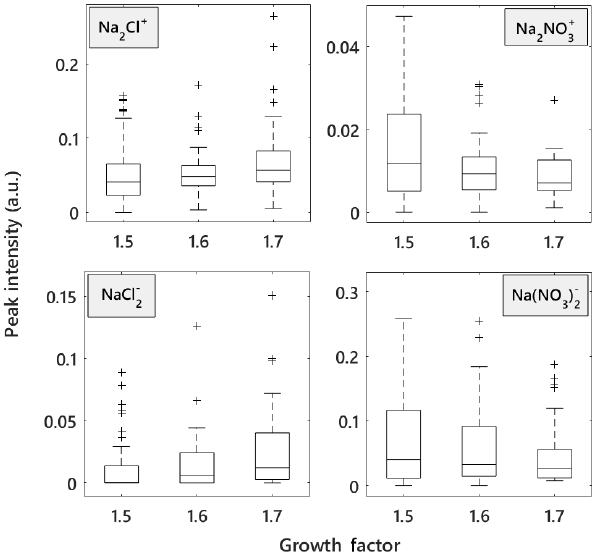
Figure 5. Statistics of peak intensities in sea salt particle mass spec- tra in the 1.5–1.7 GF range. The statistics include minimum, 25th percentile, median, 75th percentile, maximum and outliers for each GF bin.